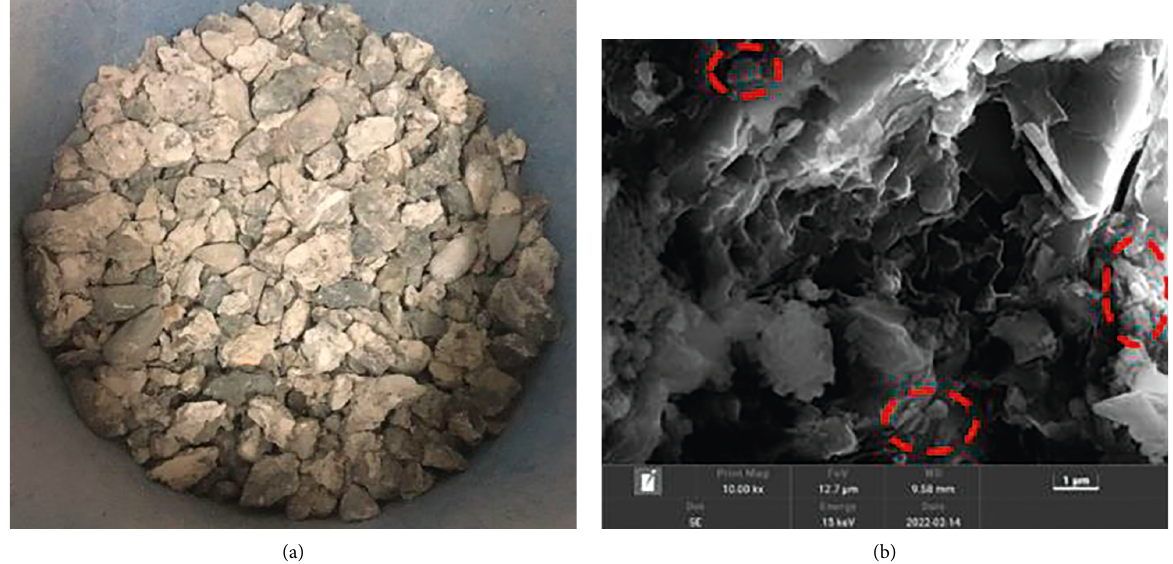
Figure 1: Morphologies of RCA. (a) Macropicture of RCA. (b) SEM of